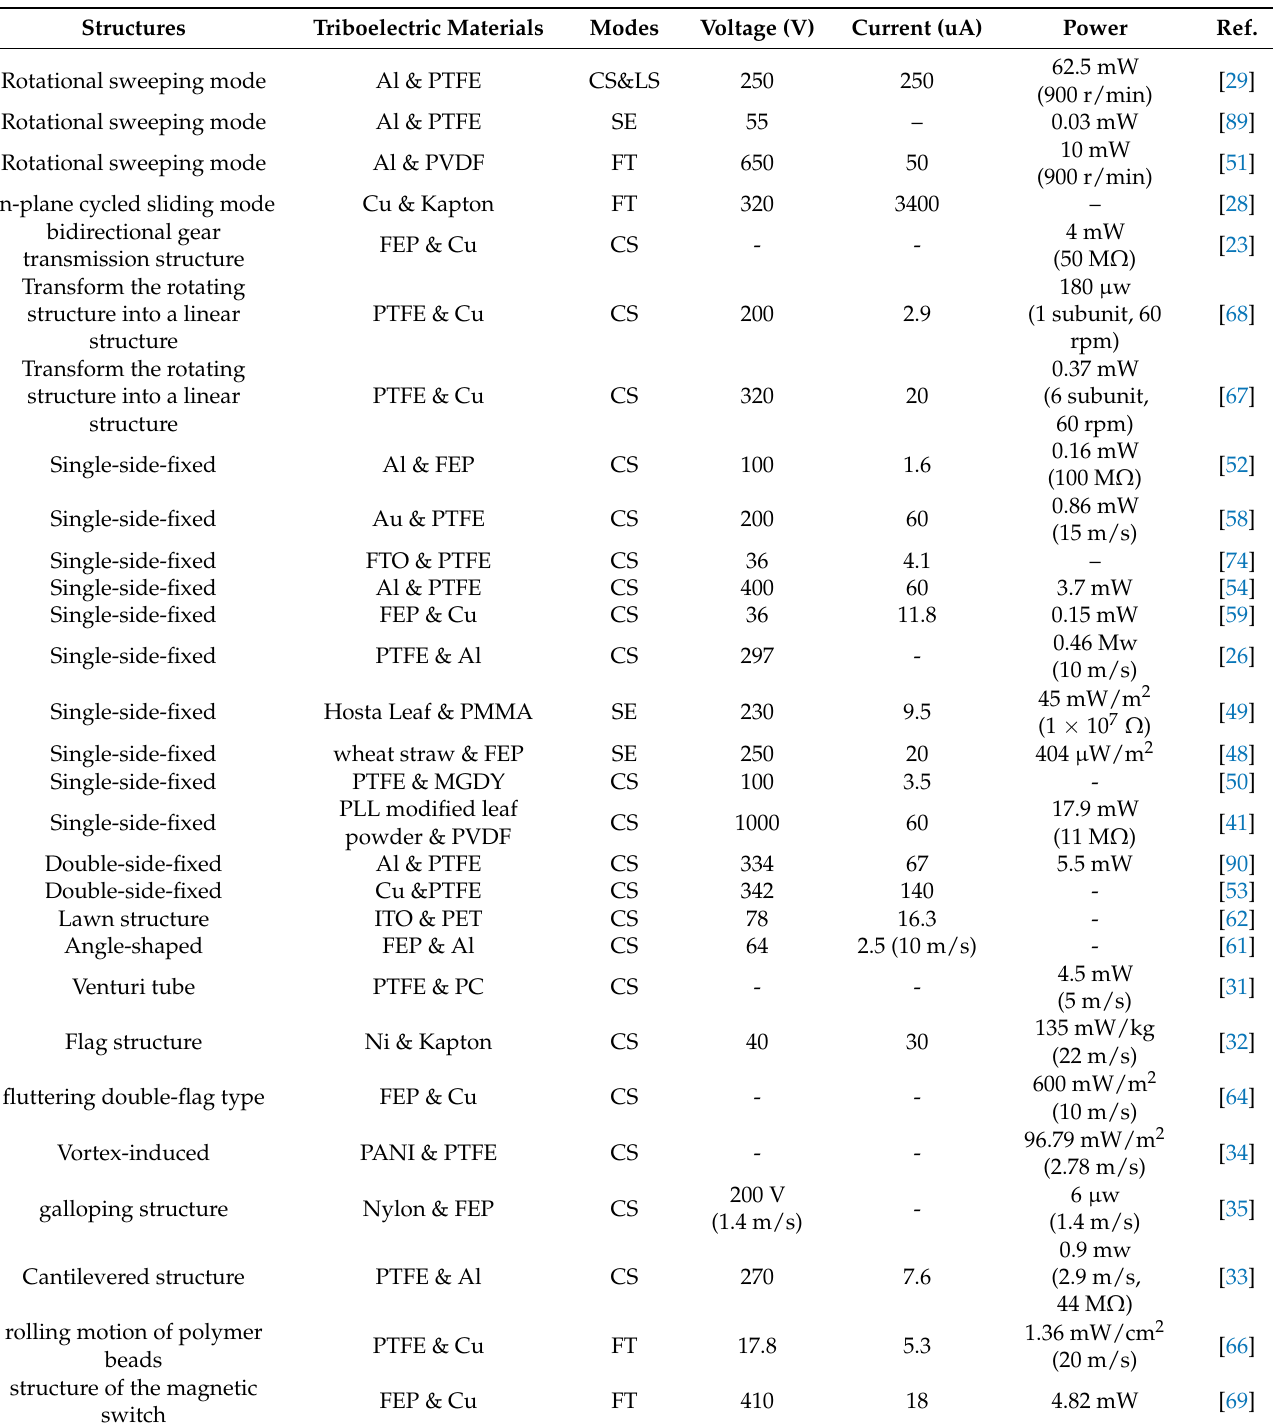
Table 2. Summary and comparison of various